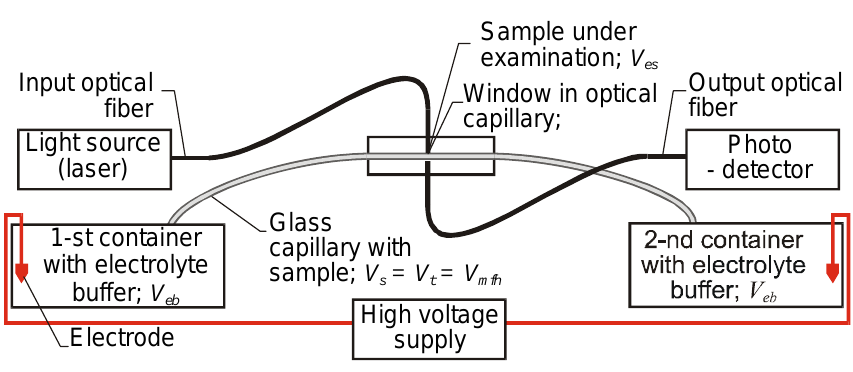
Figure 4. CE system using fiber